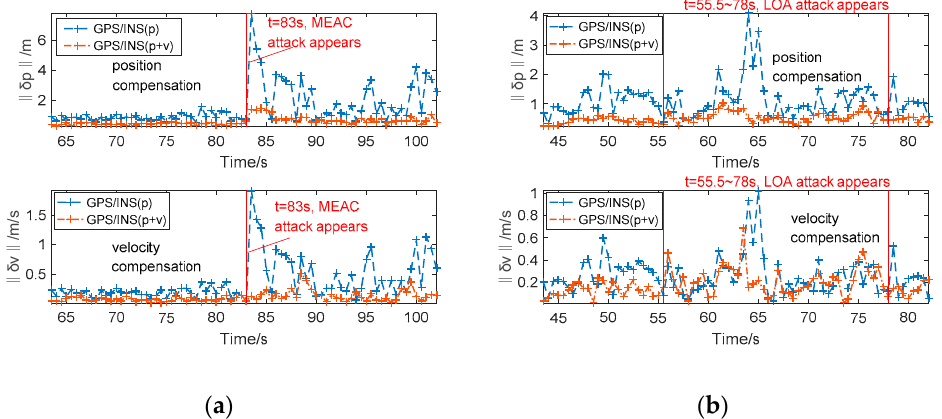
Figure 4. The position and velocity compensation norms estimated by the GPS/INS with position fusion and position/velocity fusion under MEAC attack ( a ) and LOA attack ( b ).